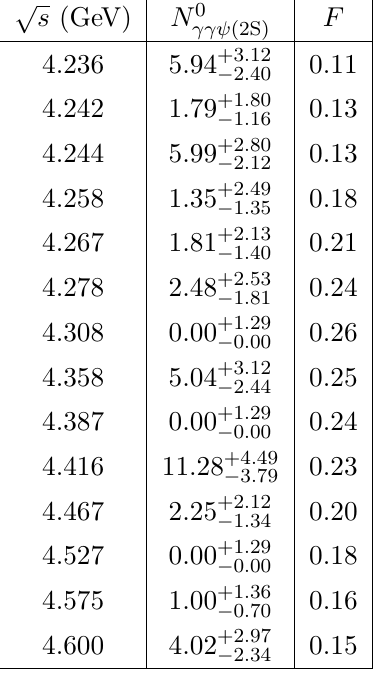
] and the γγψ (2 S )